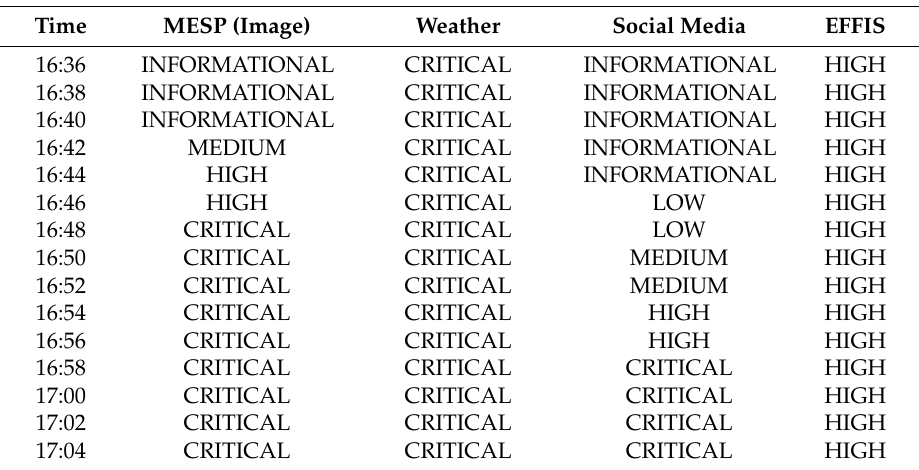
Table 6. Input used by the decision making service to estimate the fire danger level and the probability of actual fire occurrence in the conducted experiments regarding the Mati-Rafina fire incident in Greece